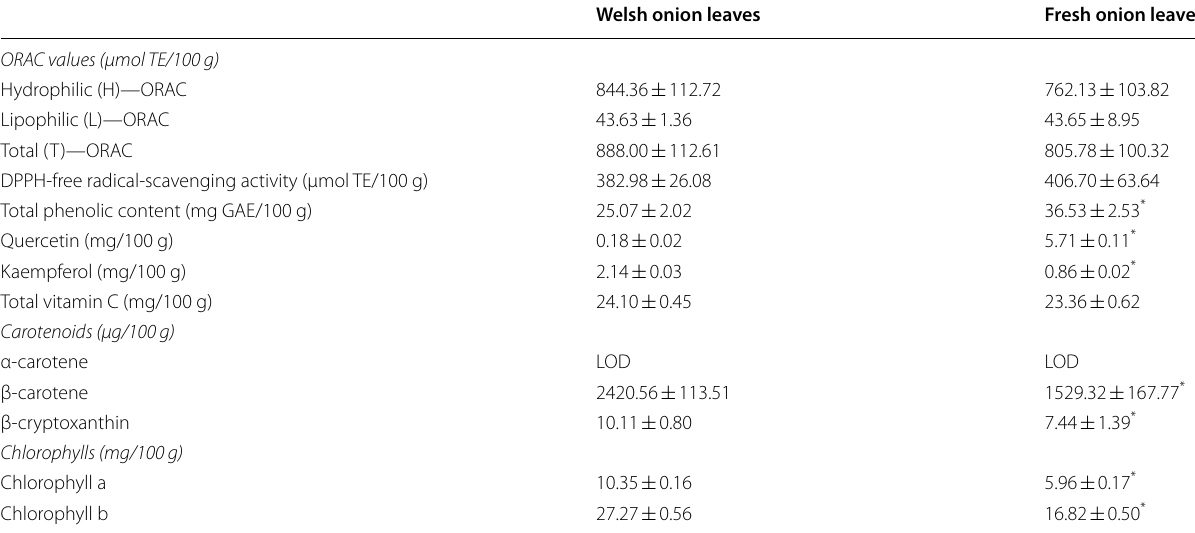
LOD, limit of detection. TE, Trolox equivalents. GAE, gallic acid equivalents. Values are the mean leaves and flesh onion leaves in each value